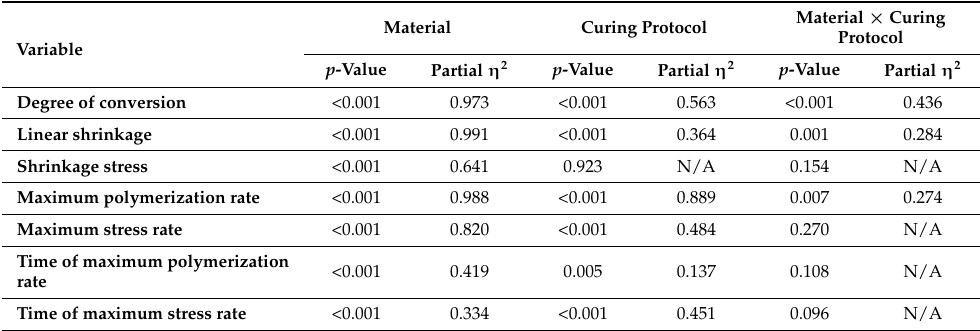
Table 2. Statistical significance ( p -values) and practical significance (partial eta-squared values) for the factors “material” and “curing